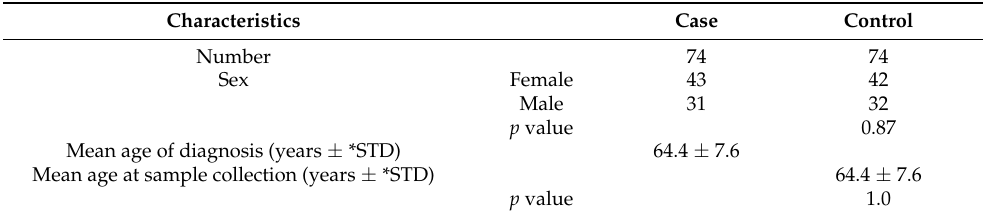
Table 1. Summary of information of subjects in this